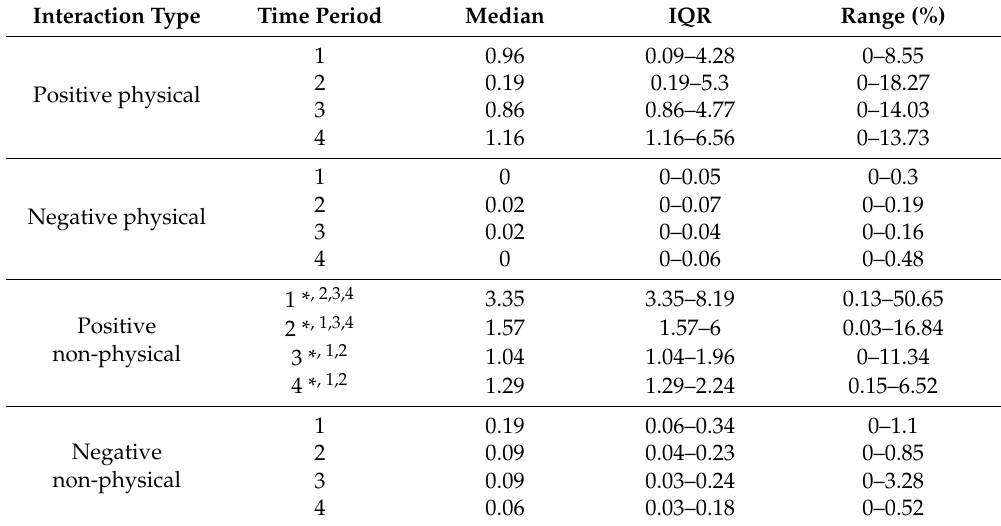
Table 4. Median recorded frequencies of social interactions given by each study